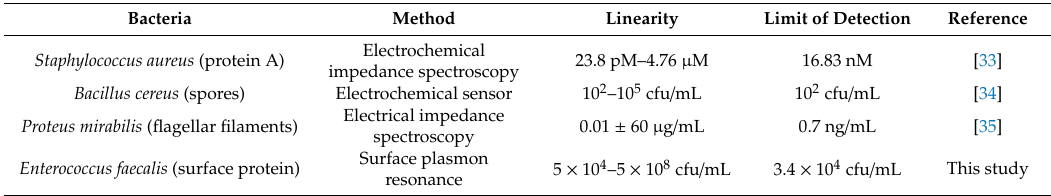
Table 3. Comparison of molecularly imprinted studies for bacteria detection.